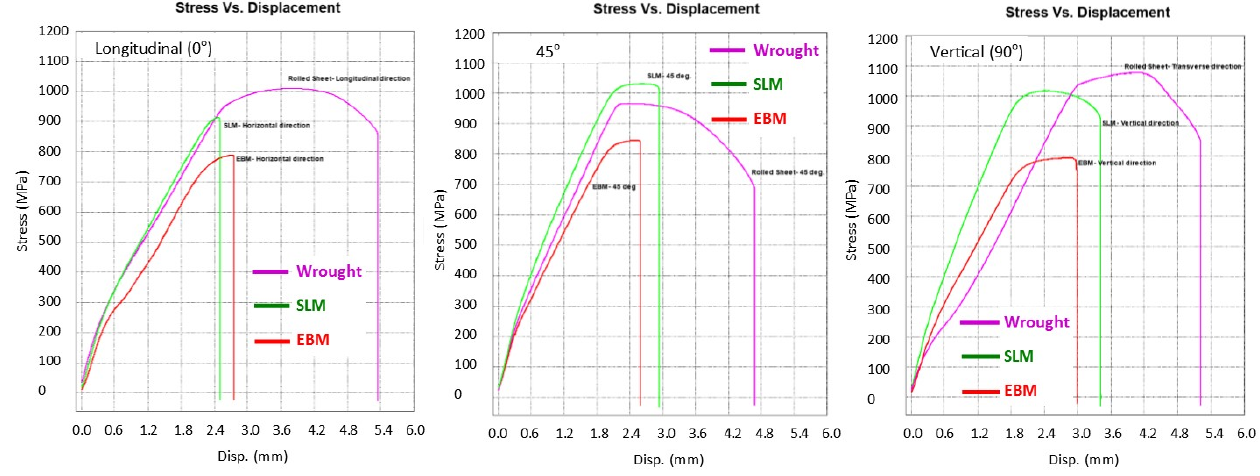
Figure 7. Stress vs displacement diagrams of samples in 0°, 45° and 90° directions. Table 3. Tensile testing results (three samples were tested for each material in each direction). Samples/Properties Yield Strength (MPa)